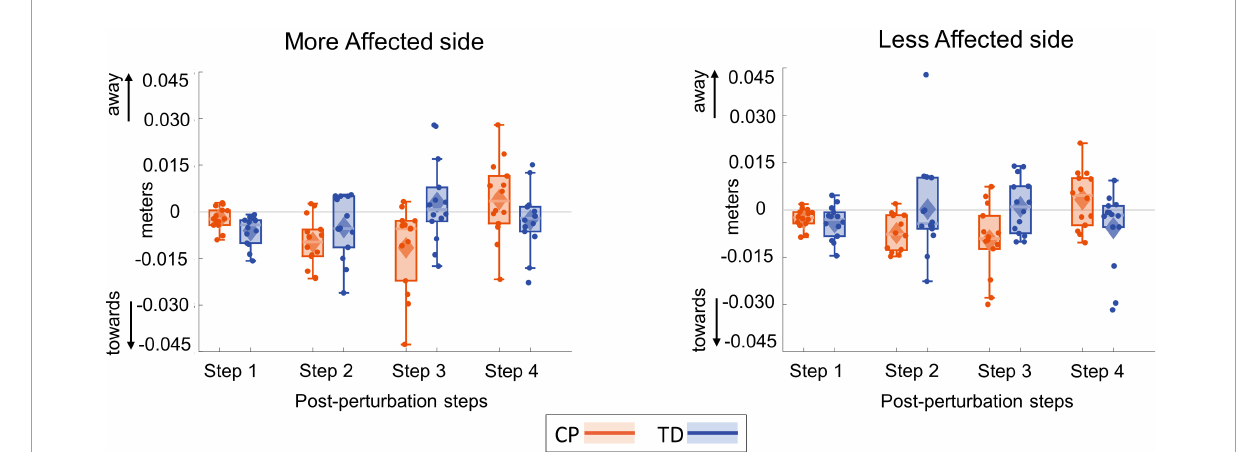
FIGURE8 Box and whisker plots for foot placement response for the first four steps following a visual fall perturbation in CP (orange) and TD (blue). Thick gray line along zero at X -axis indicates the mean of control (no fall stimulus) steps, which is subtracted from perturbation